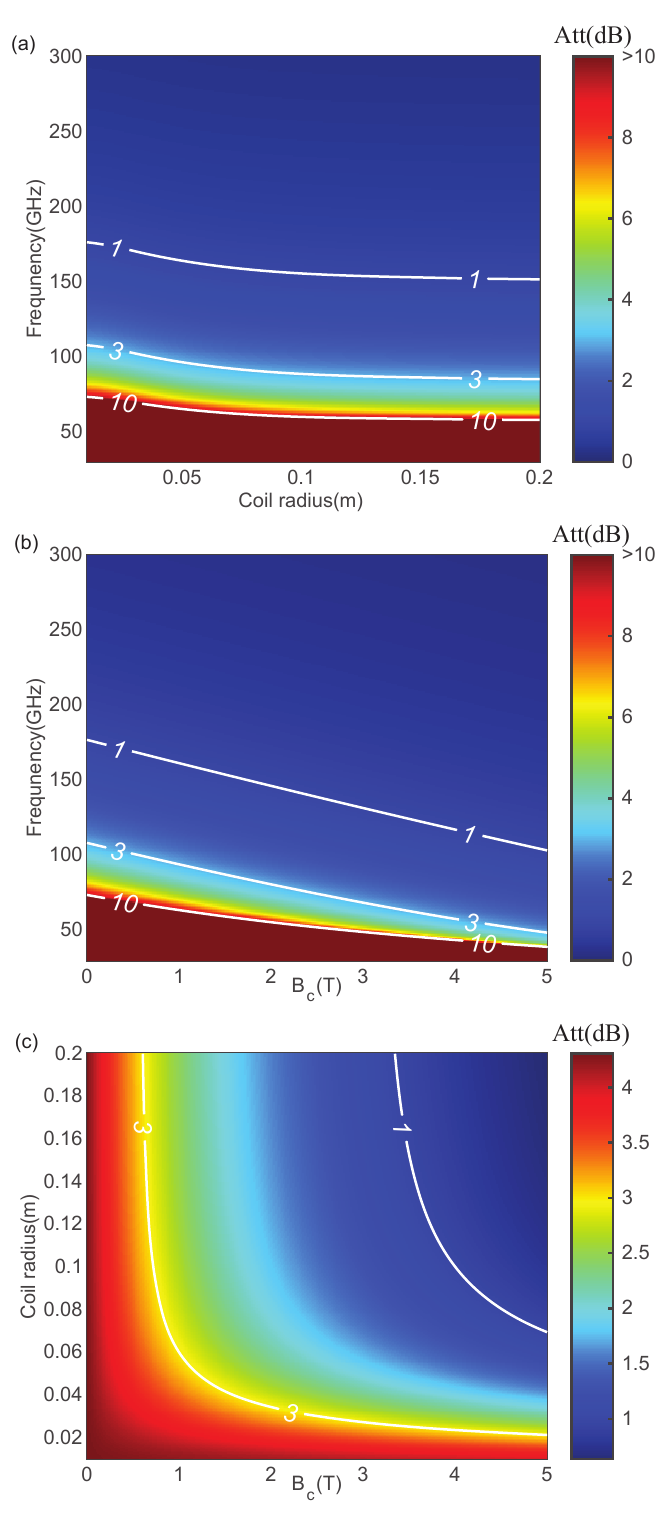
Figure 3. ( a ) Att against a and f , B c = 1 T. ( b ) Att against B c and f , a = 0.06 m. ( c ) Att against B c and a , f = 94